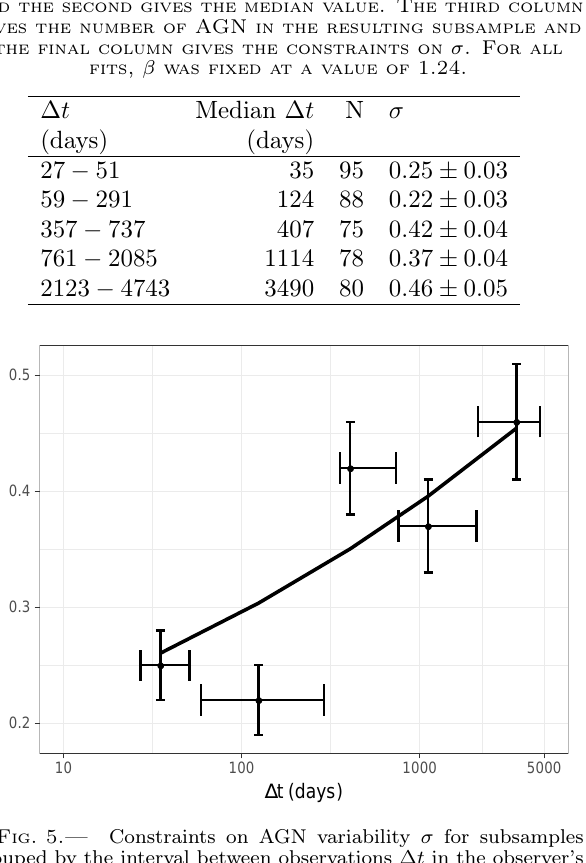
Fig. 5.— Constraints on AGN variability σ for subsamples grouped by the interval between observations ∆ t in the observer’s frame. The horizontal bars span the range of ∆ t in each subsample with the point marking the median ∆ t for each subsample. The solid line shows the variability as a function of rest frame time inter- val inferred from the structure function measurements of Vagnetti et al.